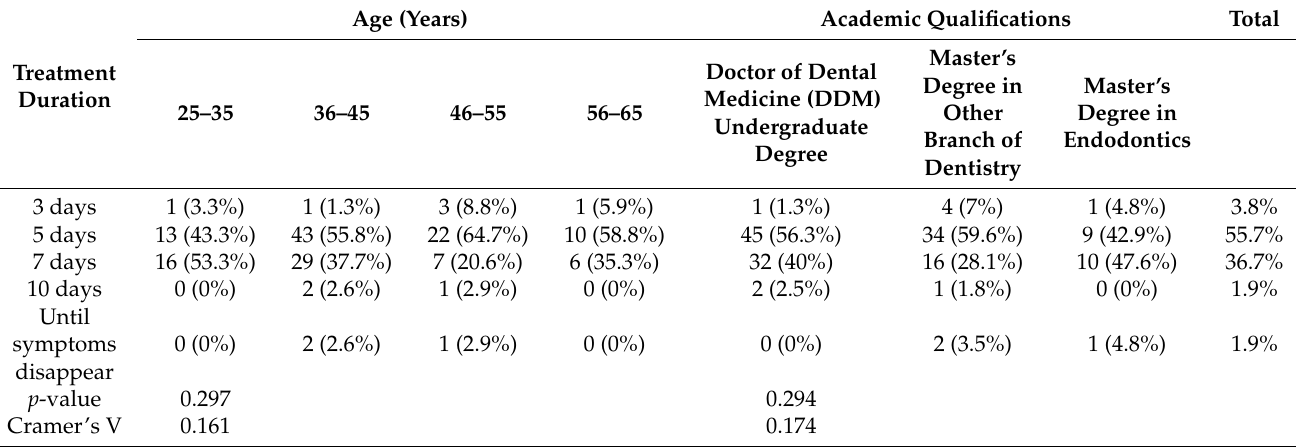
Table 1. Duration of antibiotic treatment according to the respondents’ age and academic qualifications.